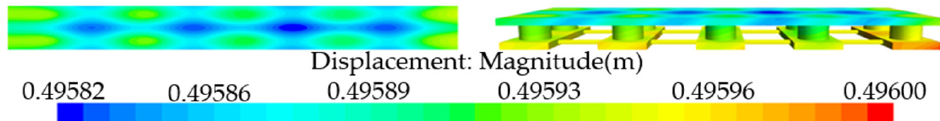
Figure 7. Deformation under working sea conditions.